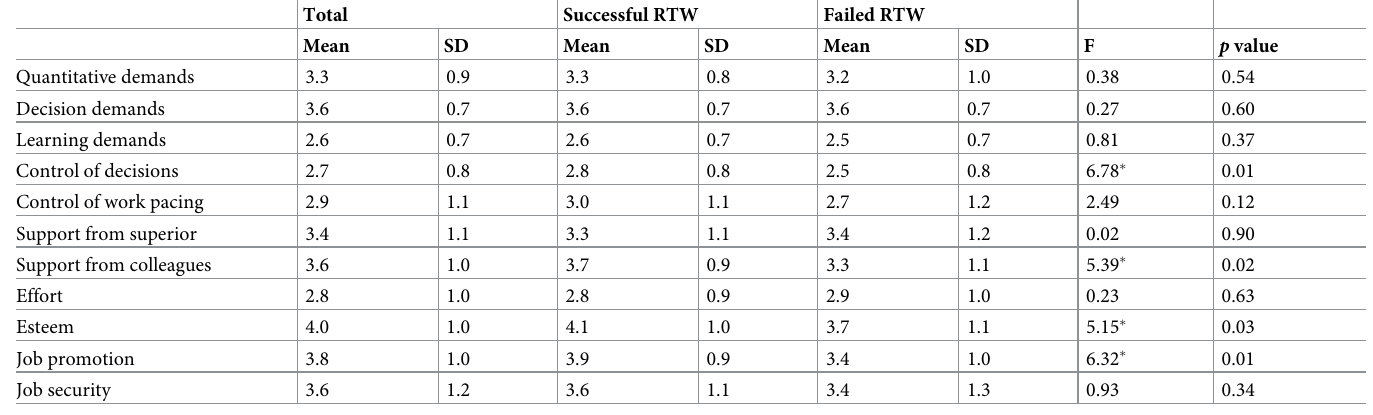
Table 2. Psychosocial work environment at baseline, according to RTW.